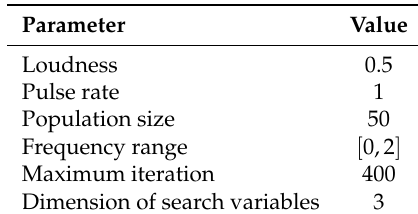
Table 2. Bat algorithm (BA) parameters.